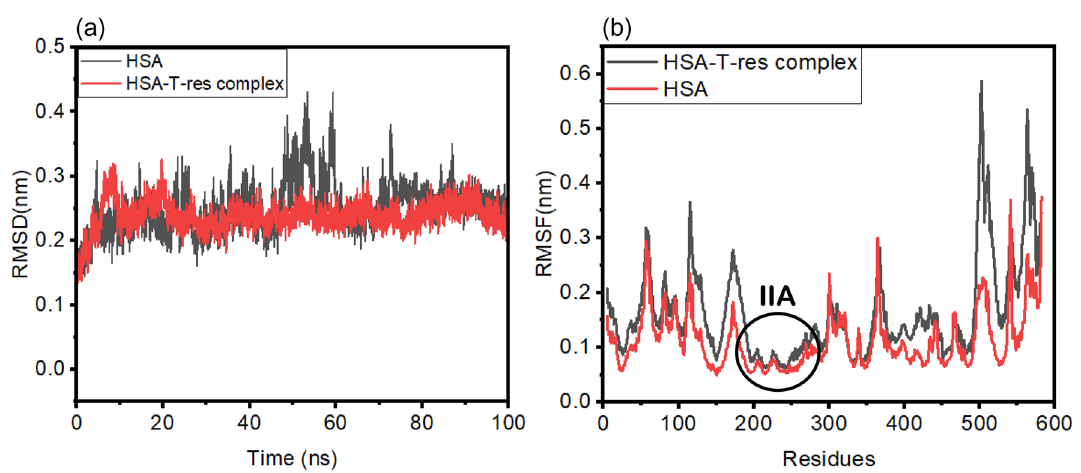
Figure 13. MD simulation analysis of HSA and trans- resveratrol binding interaction showing (a) RMSD plot for 100 ns simulation, (b) RMSF plot showing the fluctuations of the residues in HSA and HSA-T-res